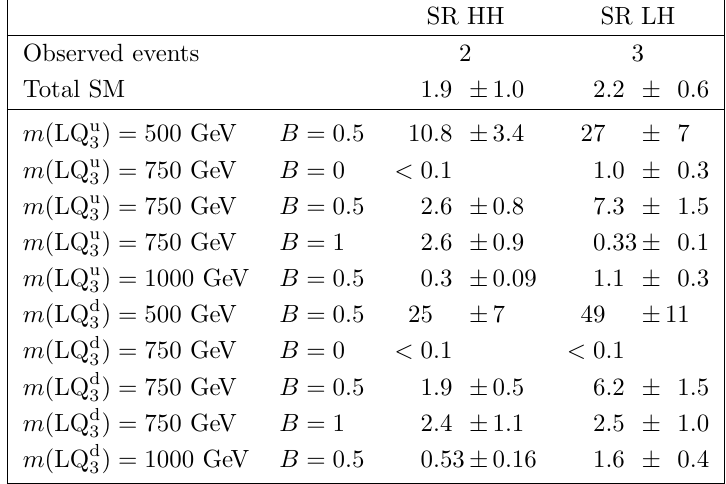
Table 6 . The expected number of SM background events obtained from the background (cid:12)t and the number of observed events in SR HH and SR LH, together with the expected number of signal events